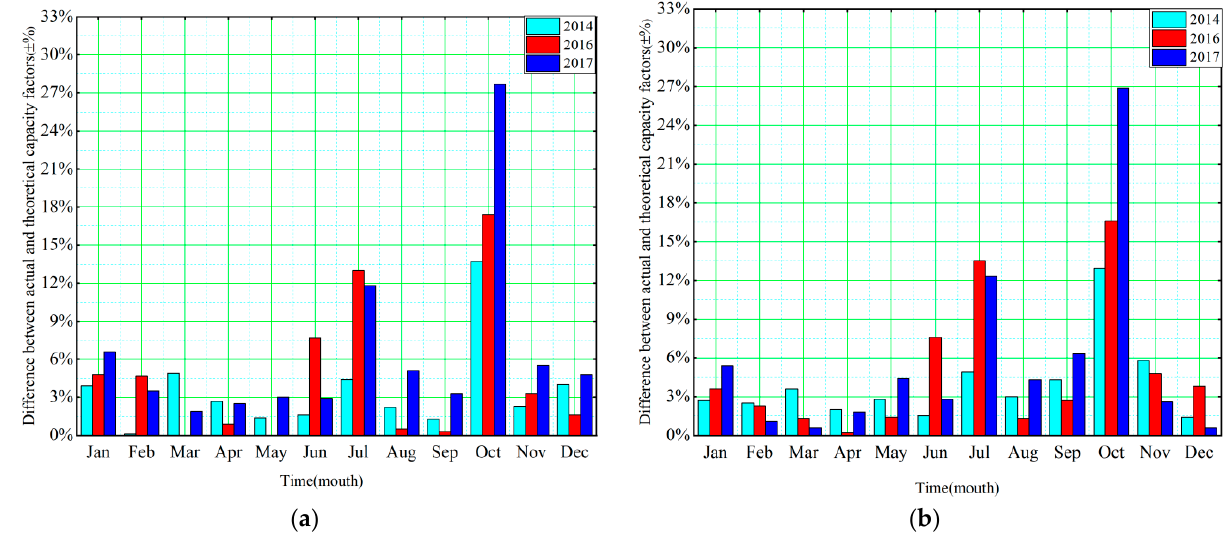
Figure 12. Difference between actual and theoretical capacity coefficients: ( a ) F1 and ( b ) F17.